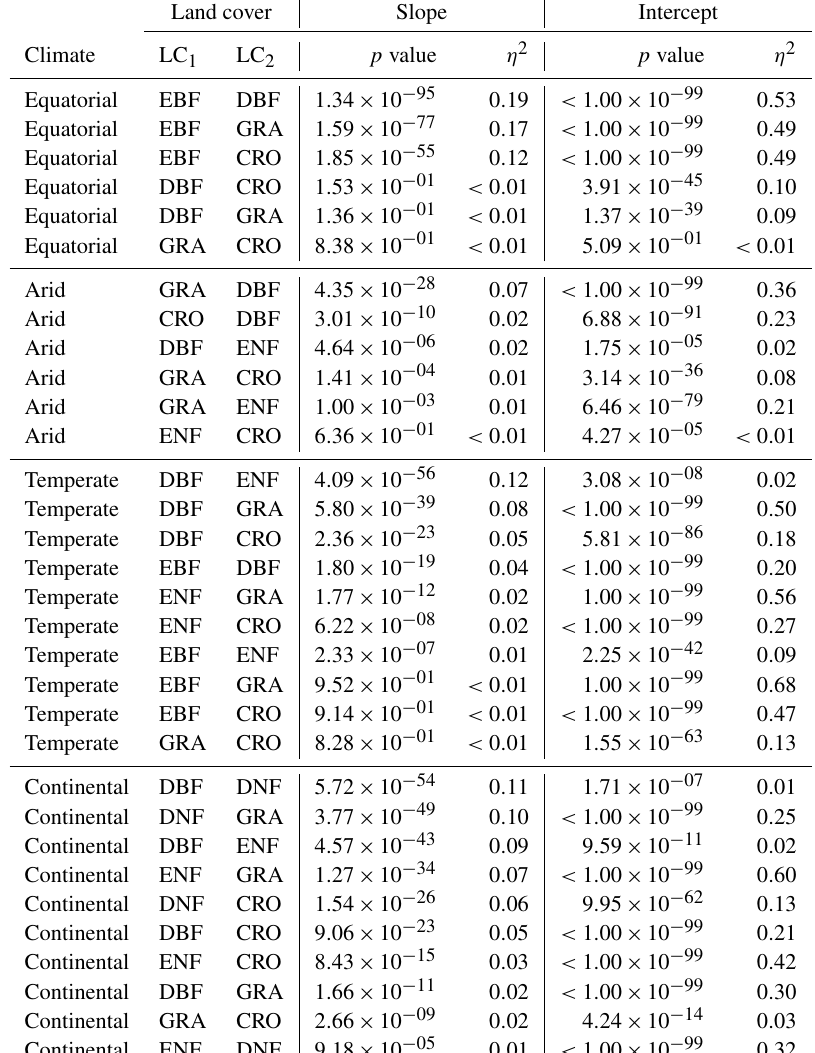
Table A1. Analysis of covariance between pairs of land covers (LC 1 and LC 2 ) in different Köppen–Geiger climate groupings. ANCOVA is only performed on the intercept under the assumption that the difference between slopes is not